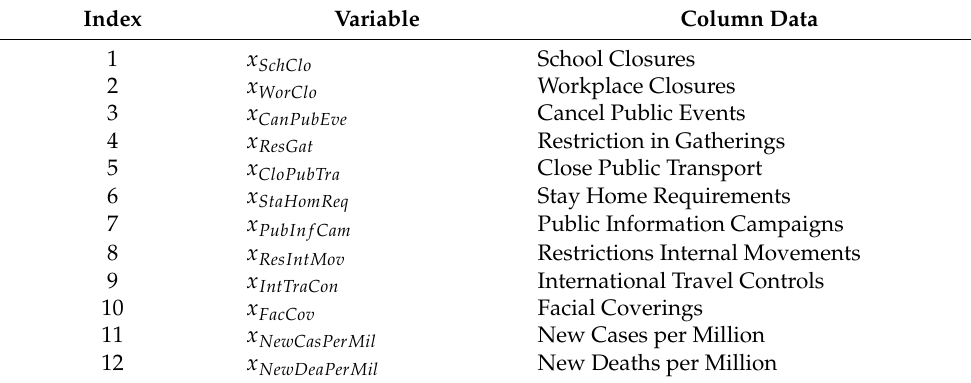
Table 1. Description of input variables into the deep learning model for daily cases and